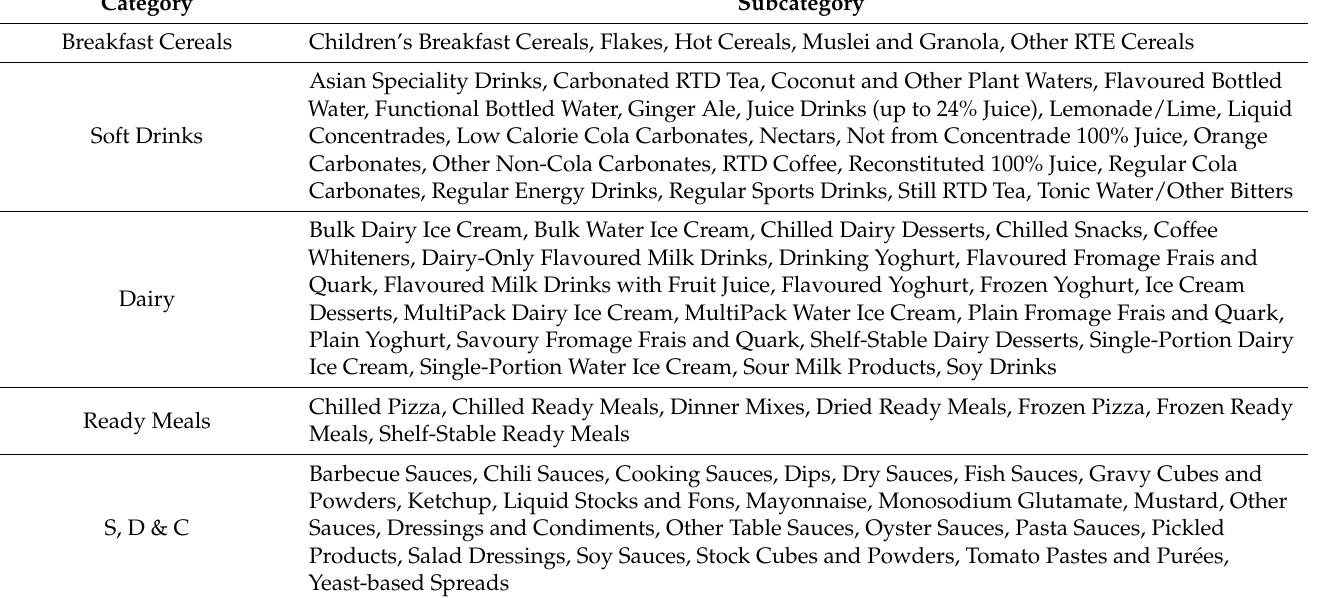
Table A1. Product categorisation and sub-categorisation in the Euromonitor Nutrition database.